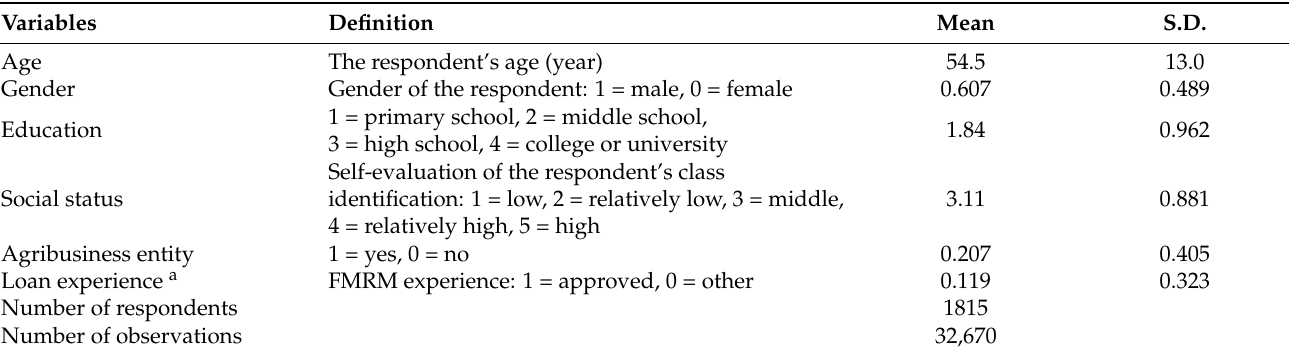
Table 2. Sociodemographic statistics.